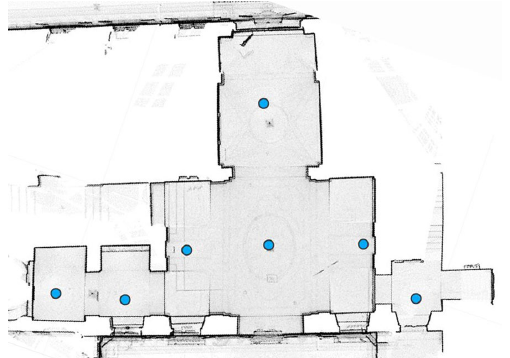
Figure 5 . Positioning of the scanning stations inside the atrium of the Capris di Cigliè Palace. To these scans must be added those carried out in the street and in the courtyard. (processing by C. López González).